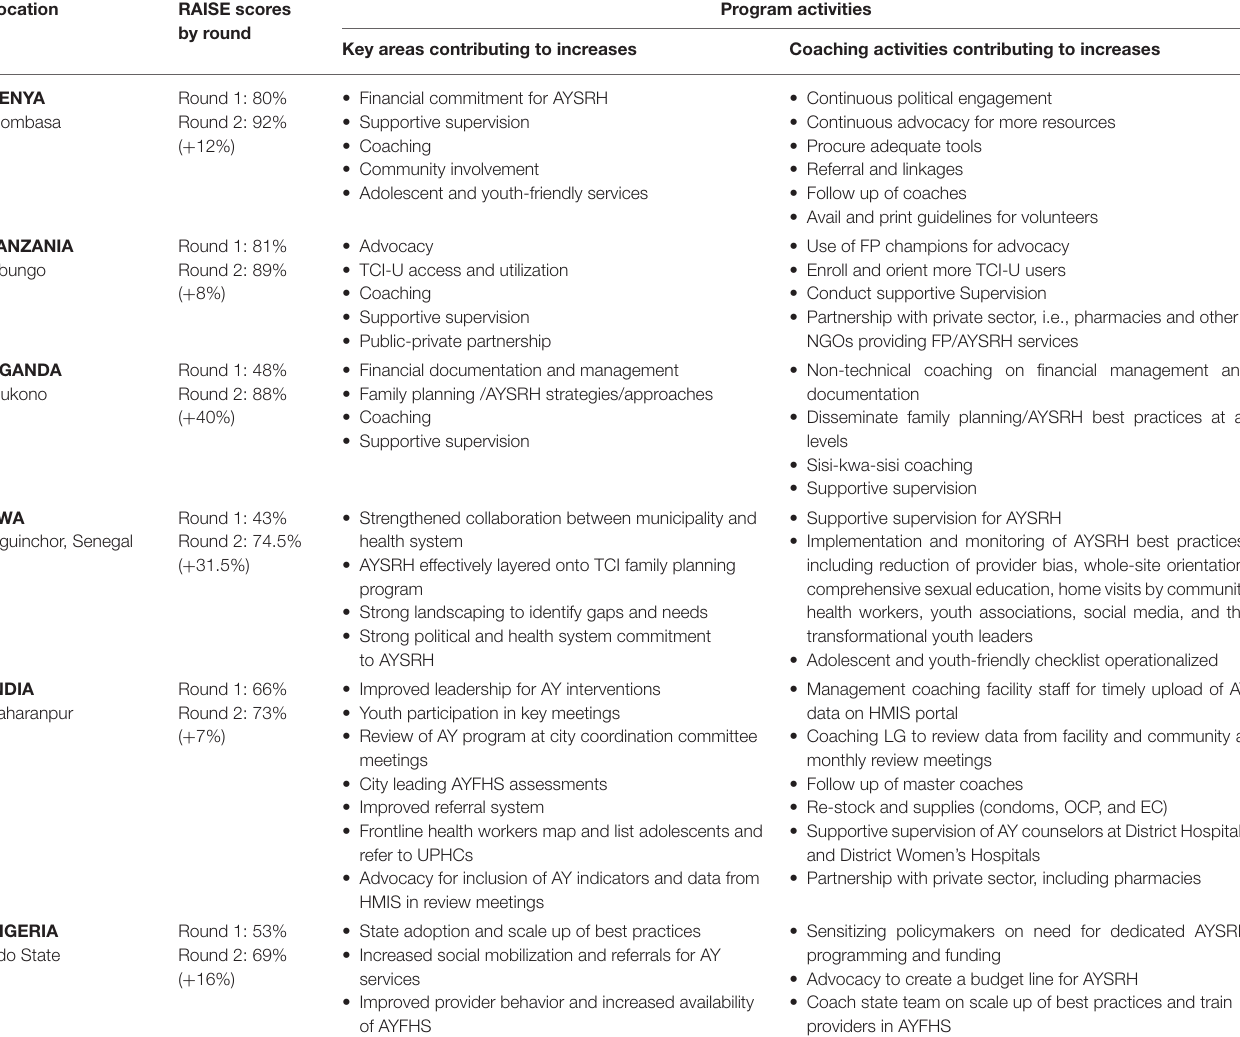
TABLE 2 | RAISE assessments for six TCI cities and actions taken leading to